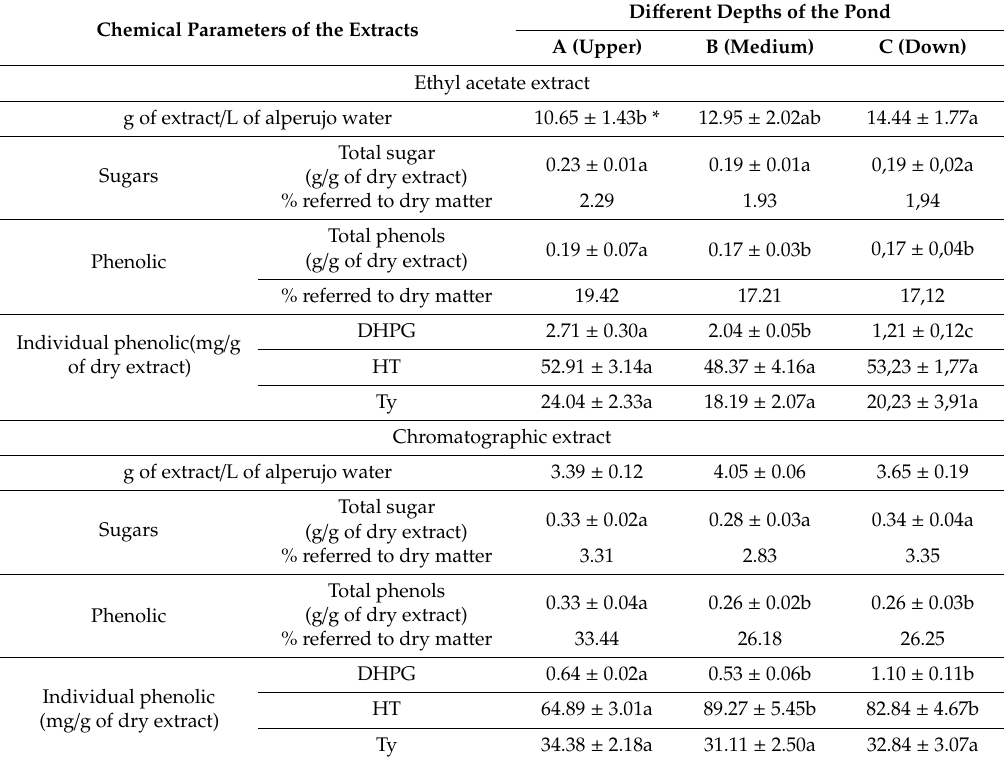
Table 2. Chemical parameters, grams of extracts, sugar, total and individual phenolics of the alperujo water extracts collected from three di ff erent depths of the pond, for the two extracts obtained from industrial process. Main individual phenolic compounds: 3,4-dihydroxyphenylglycol (DHPG), hydroxytyrosol (HT) and tyrosol (Ty).